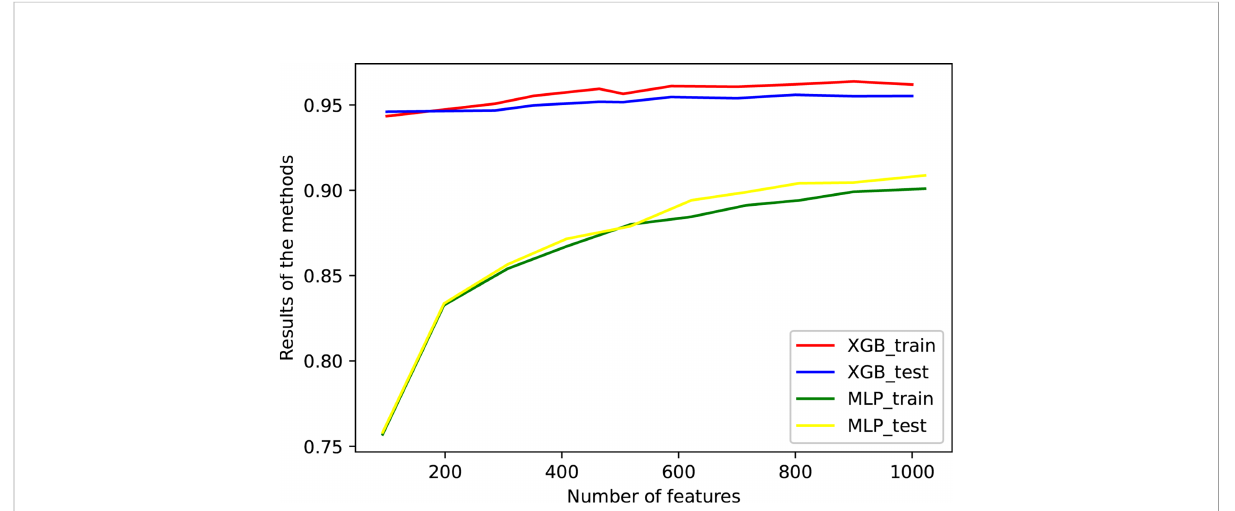
FIGURE 2 The performance of the model against the number of genes. Tenfold cross-validation was used to train the model, and some data that were not used for training were independently used for testing. XGBoost and MLP were used for classi fi cation, respectively. The accuracies of training and veri fi cation are shown in this fi